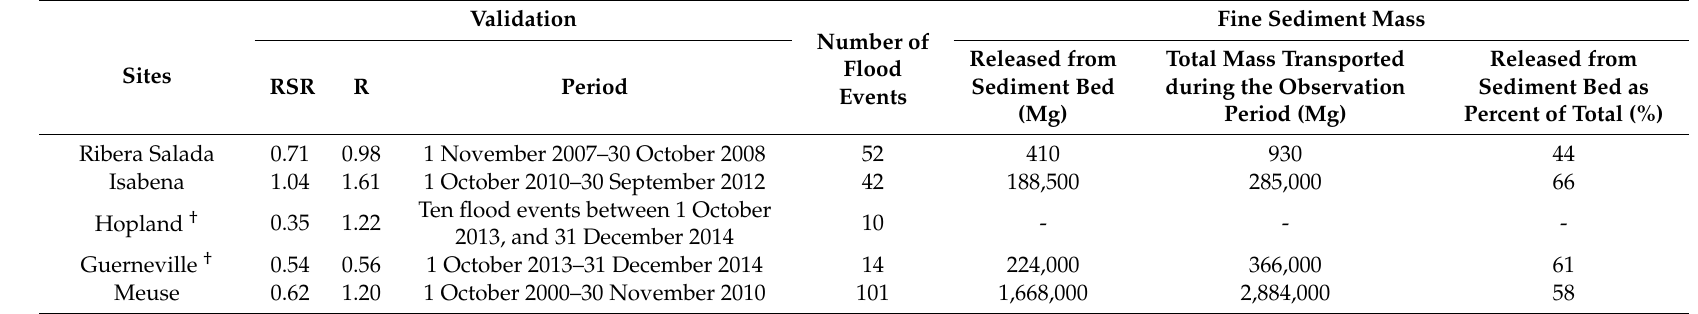
Table 3. Model validation